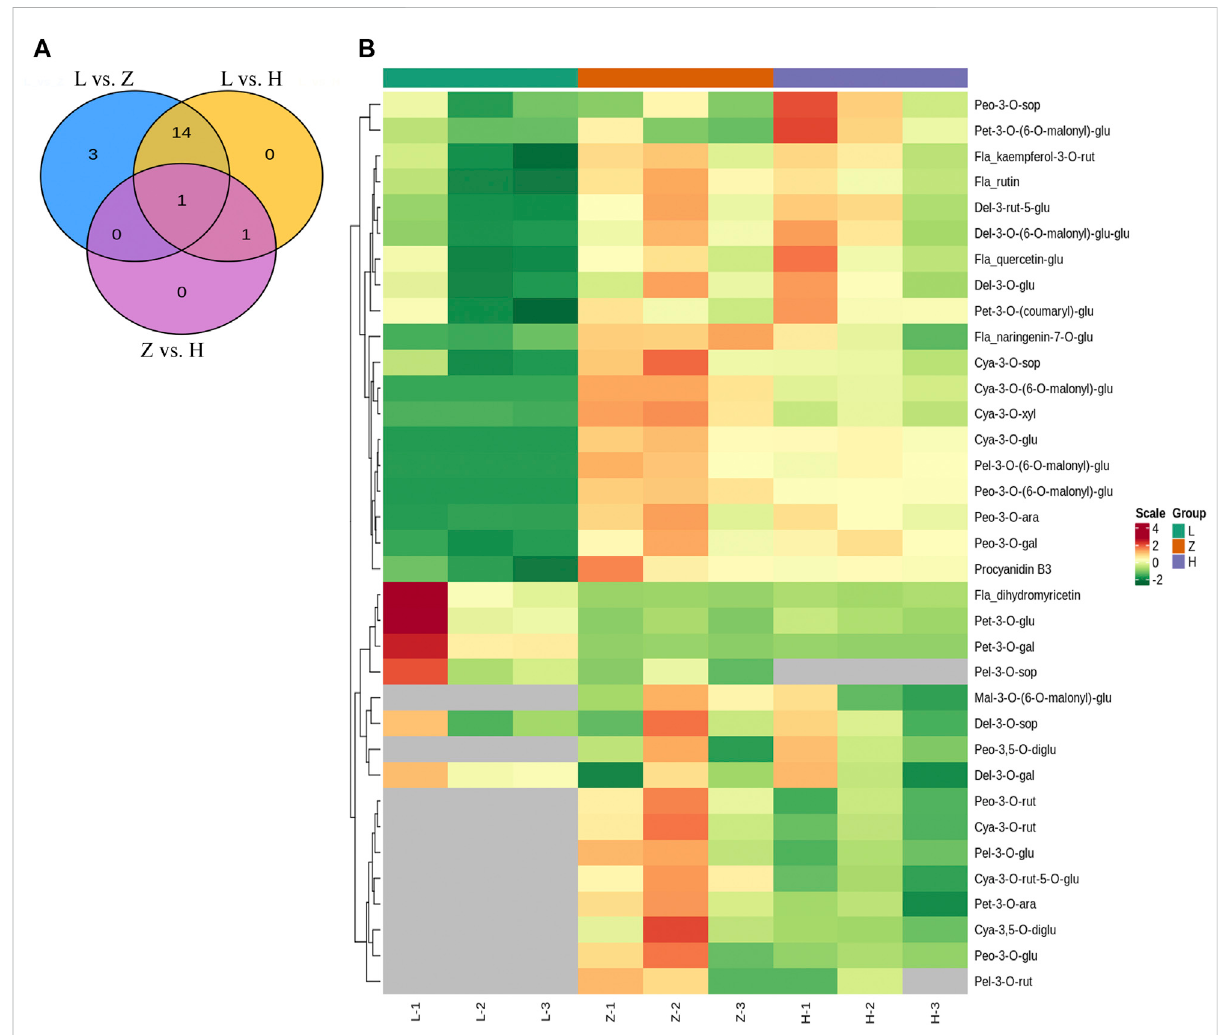
FIGURE 3 Anthocyanin pro fi le. (A) venn diagram depicting differentially accumulated anthocyanins in each group with overlap, where L, H, and Z correspondtogreen,yellow,andpurpleleaves,respectively. (B) heatmapdepictingaccumulationpatternofidenti fi edanthocyaninsingreen,yellow, and purple leaf tissues. The numbers 1, 2, and 3 correspond to each